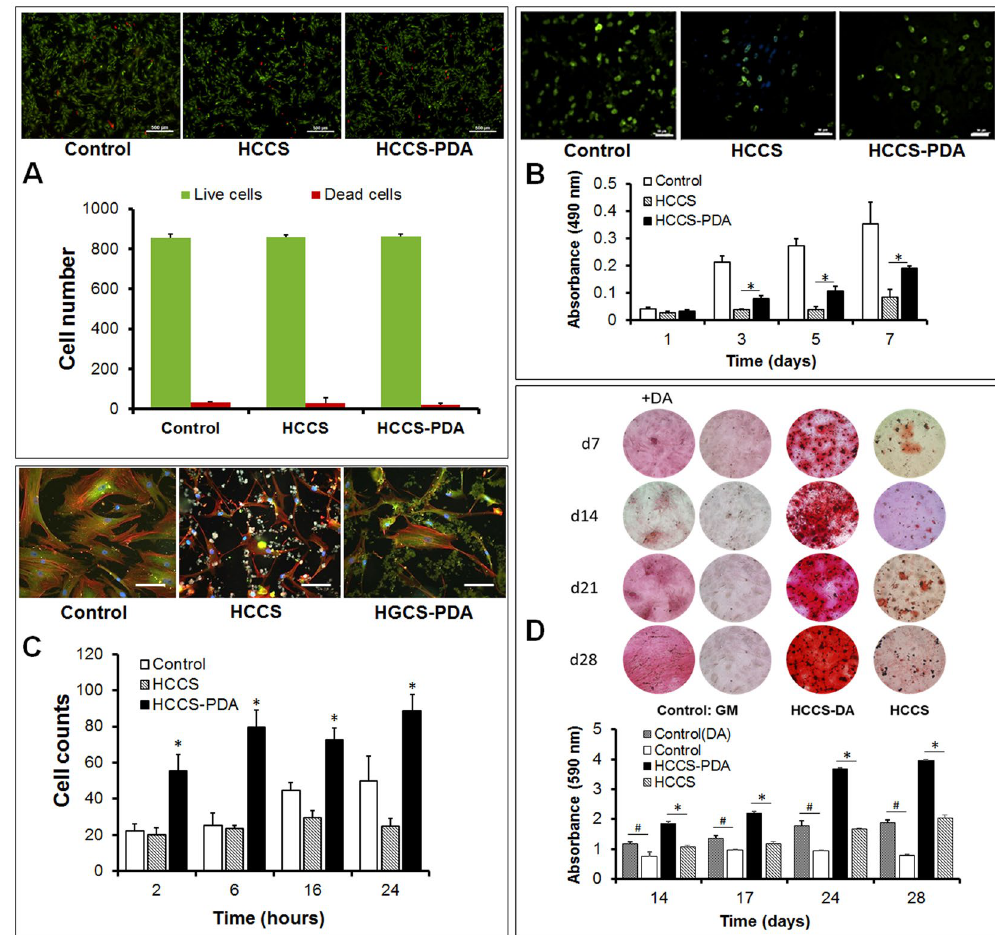
Figure 5. Live/Dead Assay was done to test the toxicity of HCCS-PDA and HCCS, with viable rMSCs staining as green by Calcein-AM and dead rMSCs staining as red by EtD-1 ( A ), scale: 500 μ m. The rMSC proliferation on the HCCS-PDA and HCCS coated dishes was assessed by MTS on 1, 3, 5, and 7 days of culturing, with a non-coated culture dish as the control ( B ), scale: 50 μ m. rMSC adhesion assay on the coated culture dish with HCCS-PDA and HCCS was performed after 2, 6, 16 and 24 hours by counting the number of attached cells. Cell morphology was observed after immunostaining with focal adhesion assay kit ( C ), scale: 10 μ m. Mineral nodule formation after Alizarin Red S staining and CPC quantification was assessed. Osteogenic differentiation was performed using 50% reduced osteogenic factors in the media. Enhanced mineralization was observed in the rMSCs cultured with growth media for 28 days on HCCS-PDA, with the formation of small minerals evident ( D ), GM: growth media and OM: osteogenic media. Extracted solution by 1% CPC was measured at an absorbance of 570 nm (n = 5, * p < 0.05 vs. in osteogenic media on HCCS, and # p < 0.05 between in growth media without DA and with DA). Image J analysis of the mineral coverage of the culture dish. Both CPC and Image J analysis yielded similar